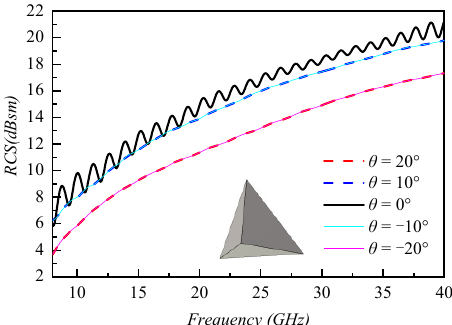
Figure 1. Variation in backward RCS with a 200 mm edge length of TCR θ offset by ±20°.